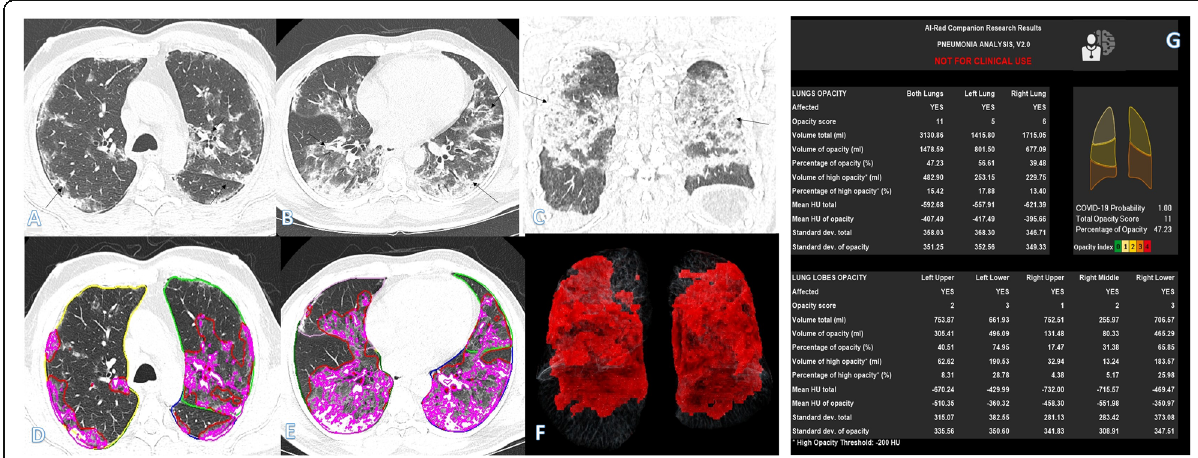
Fig. 5 A 54-year-old male with positive COVID-19 virus. CT chest shows bilateral consolidation patches with air bronchogram, crazy-paving appearance mainly peripheral and basal, and subpleural lines (arrows) with more involvement of the left upper and both lower lobes (arrows in a – c ). Total severity score = 11. Quantitative analysis ( d – g ) by AI-Rad Companion Research CT Pneumonia Analysis was presented with the measured parameters seen in table ( g ). Quantitative total opacity score was